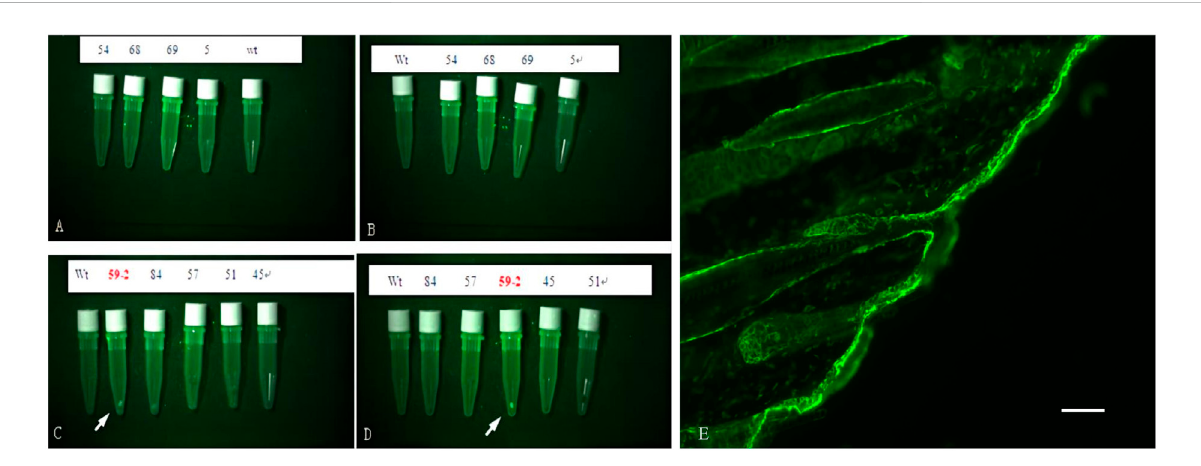
FIGURE 3 The detection ofGreen Fluorescent Protein (GFP) inskin ofF0 transgenic mice. (A) , (B) , (C) and (D) are the fl uorescence microscope analysis of theskinofthetransgenic mice.Wtiswilde-typecontrol.GFPwasdetectedinline59,indicatedwithwhitearrow. (E) The fl uorescenceProteininskin tissue of ovine β -catenin transgenic mice, the scale bar: 60 μ